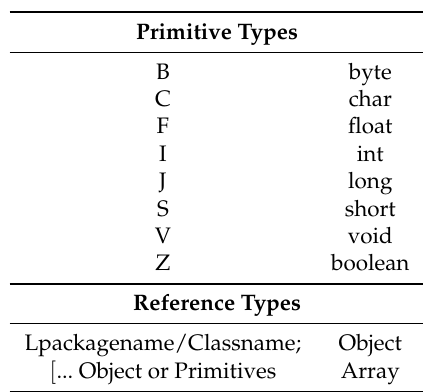
Table 1. Types in